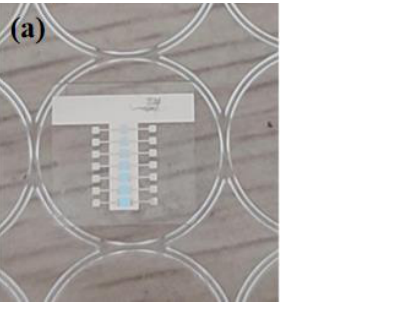
Figure 1. Image of ZATO TFTs device: ( a ) Practical and ( b ) schematic map of cross-section. Experimental schemes for ZATO films in this work were determined by Taguchi orthogonal design. Eighteen schemes were obtained with sputtering pressure of 3 levels (3 mTorr, 5 mTorr and 8 mTorr); oxygen/argon ratio of 3 levels (0%, 5% and 10%) and annealing temperature of 6 levels. The five most represented groups were selected for research, as shown in Table 1.